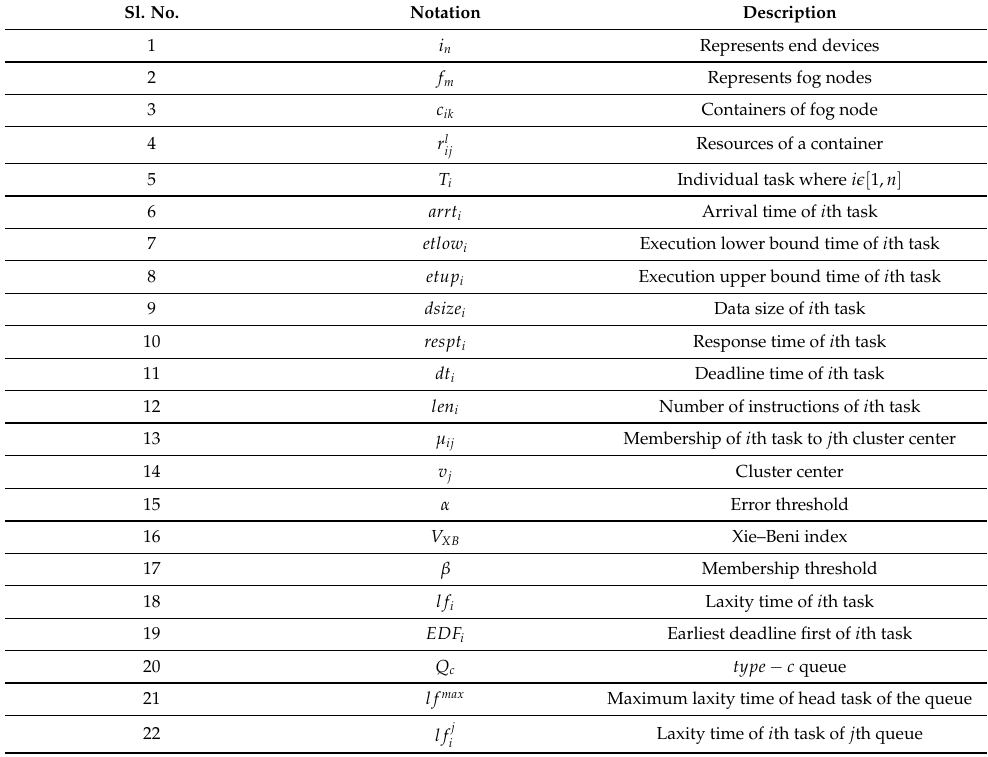
Table 3. Notations and description. Sl.